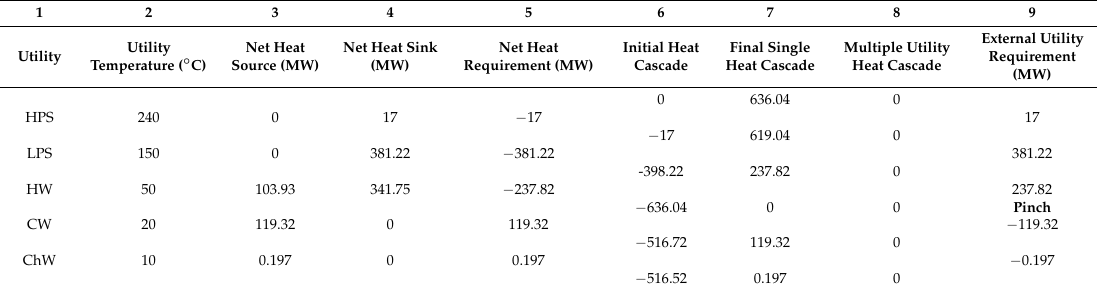
Table 8. TS PTA for all industrial